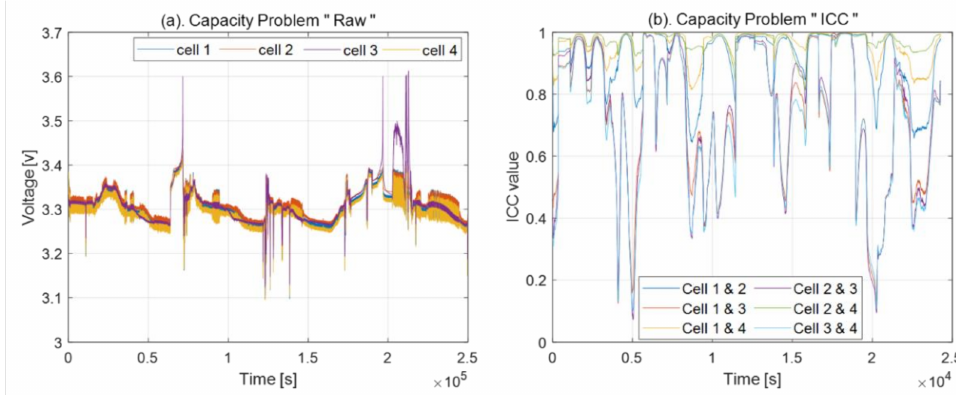
Figure 14. Capacity problem (( a ) voltage and ( b ) ICC